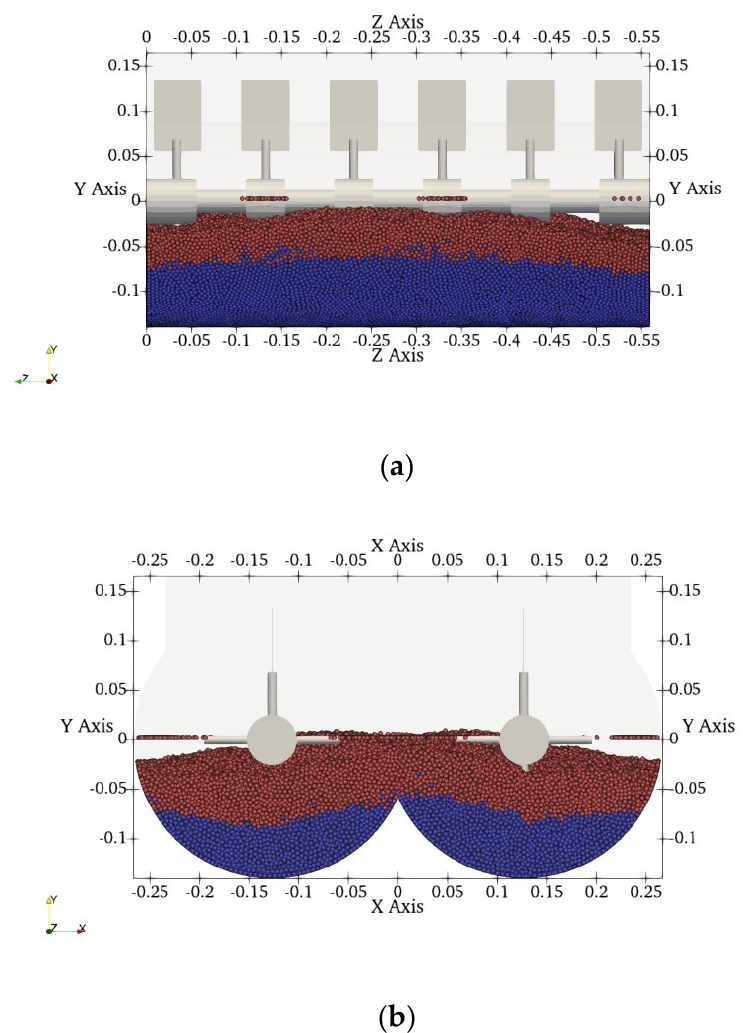
Figure 4. The initial state of the mixing system after loading all the particles; ( a ) Side view, ( b ) Front view.